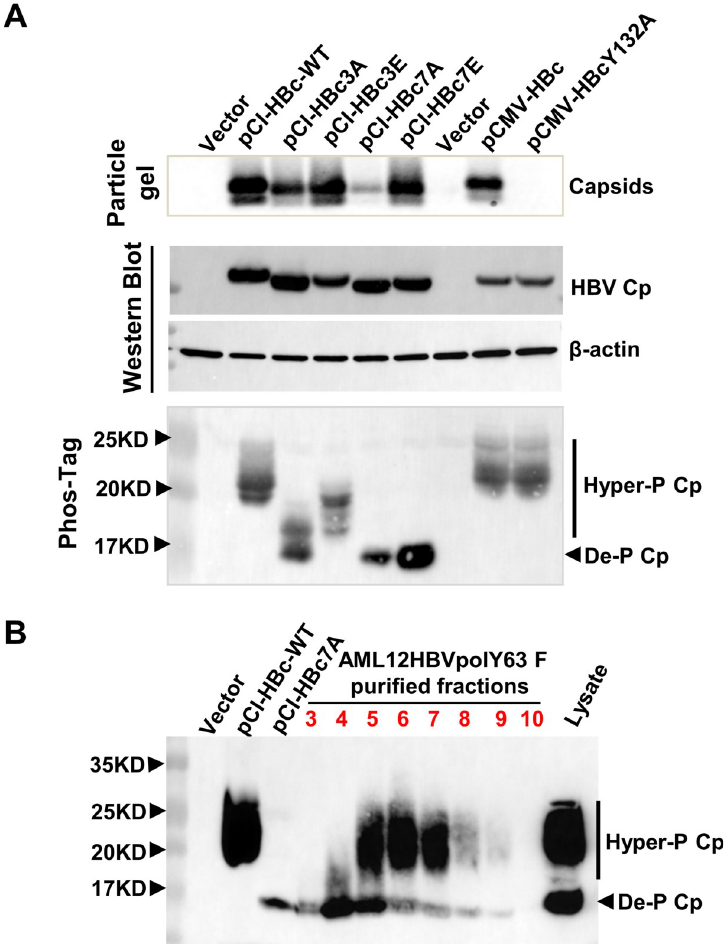
Fig 8. Phos-tag gel electrophoresis analysis of HBV Cp phosphorylation status. ( A ) 293T cells were transfected with the indicated plasmids and lysed with lysis buffer at 3 days post transfection. Intracellular capsids were determined by particle gel assay. HBV Cp in total cell lysates were resolved by electrophoresis in a NuPAGE 12% Bis-Tris Protein Gel and detected by a western blot assay. β -actin served as a loading control ((lower panel). The same samples were resolved by phos-tag gel electrophoresis and Cp was detected by Western blot assay with antibody HBc-170A. ( B ) The lysates of pCI-HBc and pCI-HBc-7A transfected 293T cells and total lysates of AML12HBVpolY63F cells as well as samples of sucrose gradient centrifugation fractions 3 to 10 described in Fig 4 were resolved by a 12.7% Phos-tag gel electrophoresis and proteins were transferred onto a PVDF membrane. HBV Cp was detected with antibody HBc-